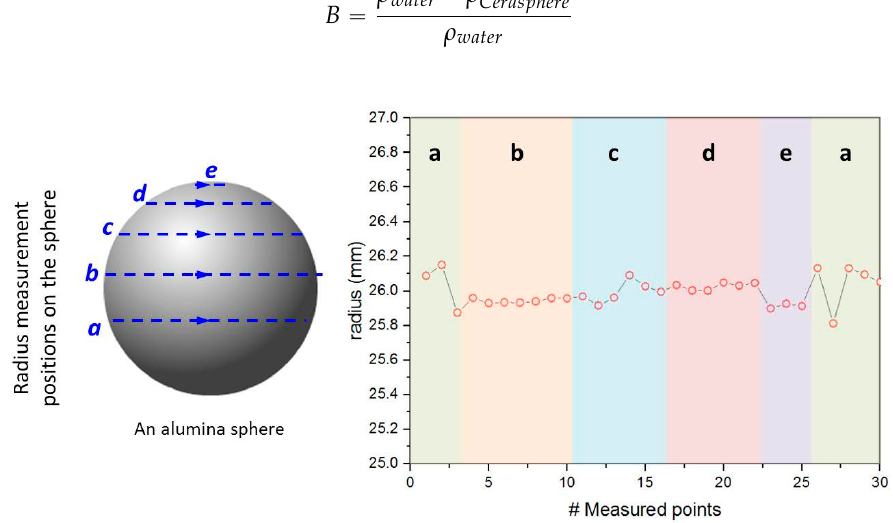
Figure 5. Radius measurement results of an alumina sphere, where the blue dotted lines are the measured areas in the sample.